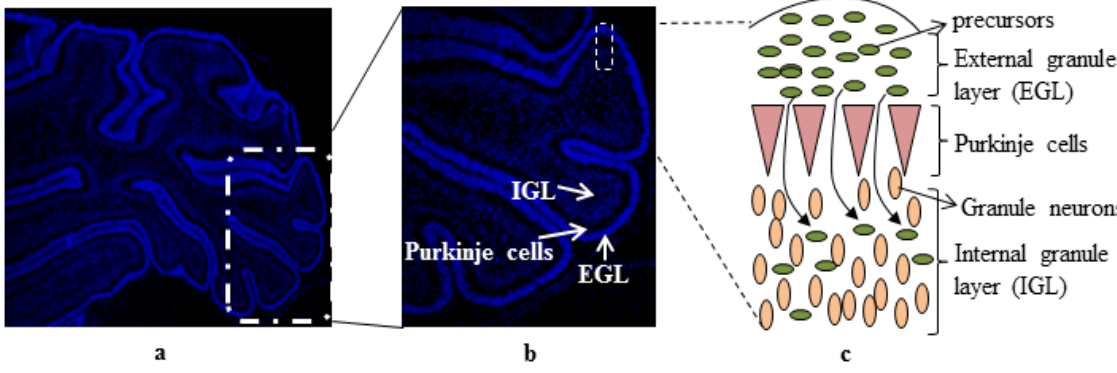
Figure 1. Cross section of postnatal day seven rat cerebellum ( a ), showing external granule layer (EGL), Purkinje cells and internal granule layer (IGL) ( b ). During cerebellar development, granule cell precursors (GCPs) present in EGL proliferate and differentiated into mature granule neurons. Mature neurons start migrating past the Purkinje cell layer to form the internal granule layer (IGL) ( c